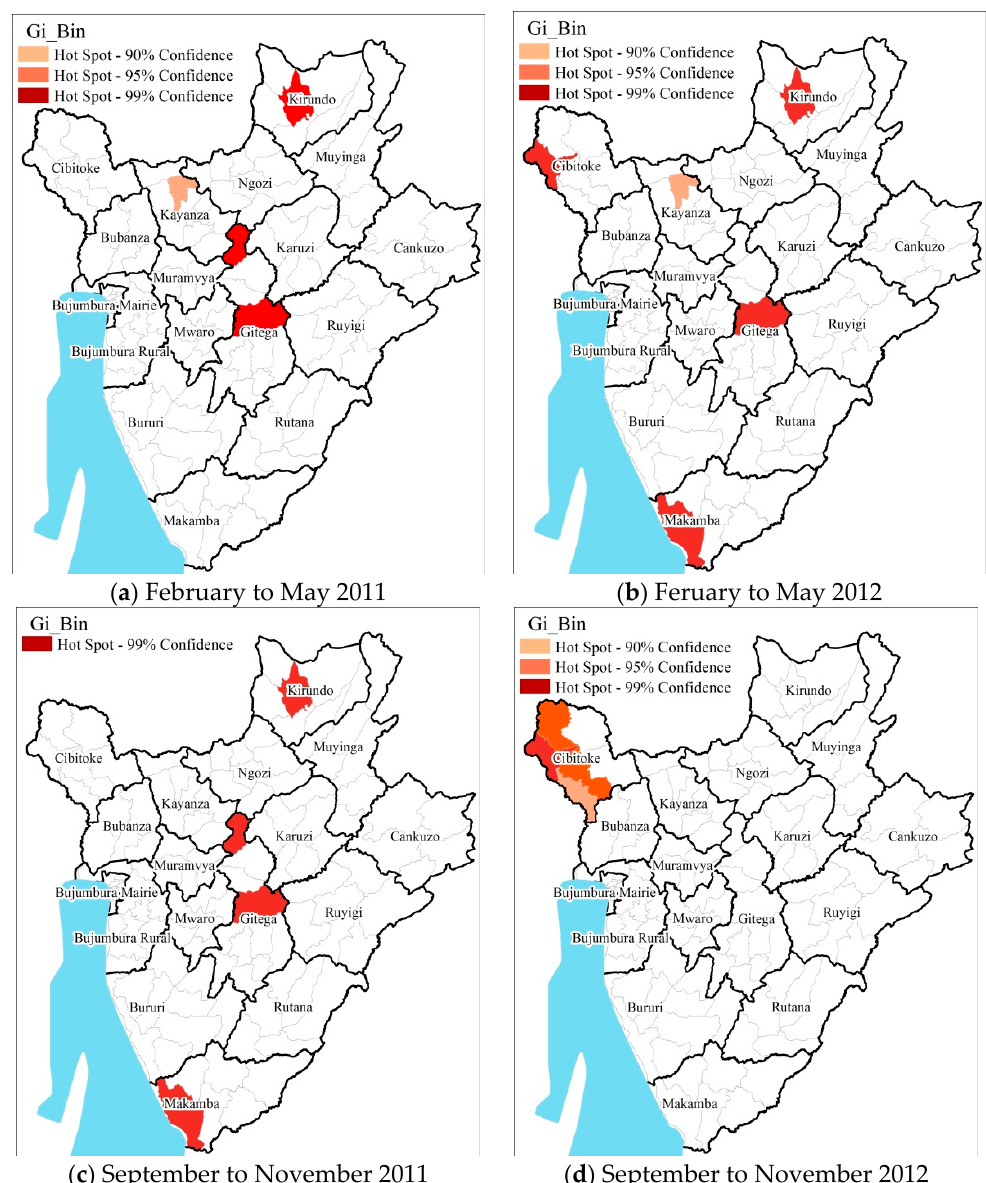
Figure 4. Results of seasonal scale hotspots analysis during the wet seasons ( a ) February to May 2011; ( b ) Feruary to May 2012; ( c ) September to November 2011; ( d ) September to November 2012. All the statistically significant (at 90% and above confidence interval) hot spots have been highlighted in shades of red.